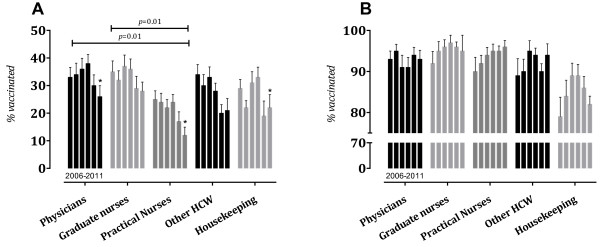
Seasonal influenza (Panel A) and HBV (Panel B) vaccination coverage among healthcare workers in Croatian hospitals, stratified by occupation and year. The bars represent medians with IQRs. Statistical significance was calculated using the Kruskal–Wallis and post hoc multiple comparison tests. Statistical analysis showed significant differences among physicians, graduate nurses and practical nurses (p = 0.01). Furthermore, significant decreases in 2011–2012 were observed (*, p < 0.05)) (Panel A). Meanwhile, HBV vaccination coverage was the lowest among housekeeping personnel (p = 0.001) (Panel B).